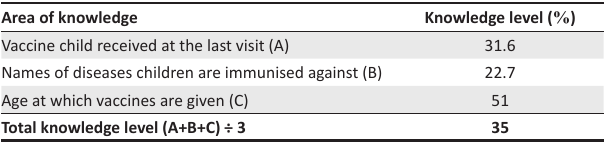
TABLE 1: Knowledge level of parents. Area of knowledge